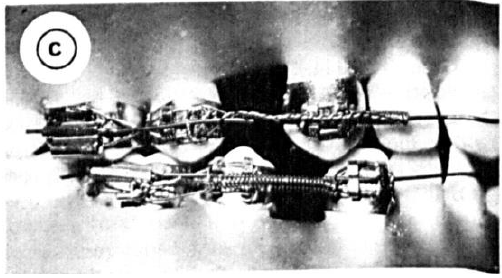
Figure (7): Canine distalization using coil spring compressed by a tie-back ligature in the upper arch and using tied back expanded coil spring in the lower